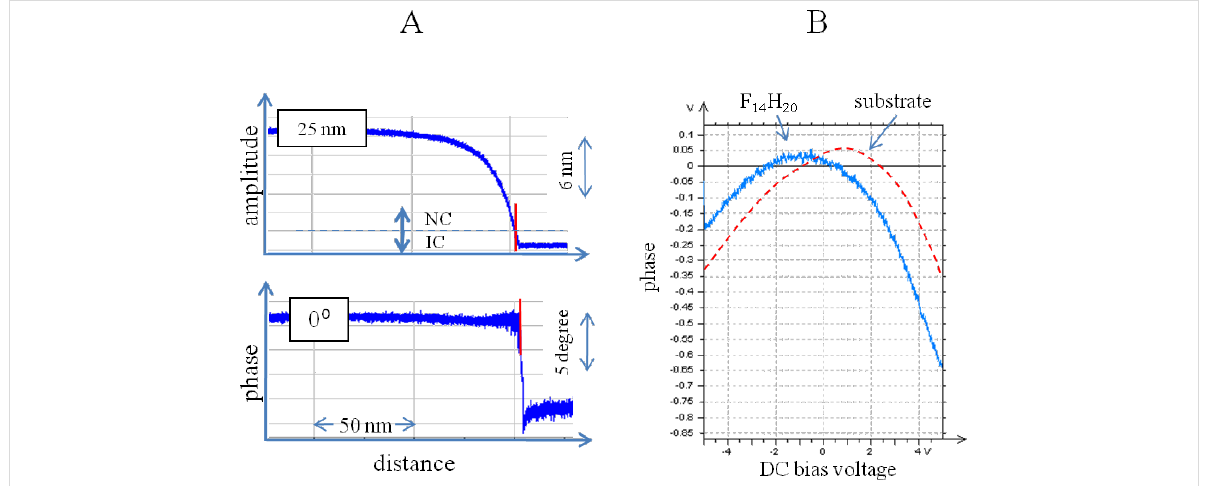
Figure 2: A – Graph showing a temporal change of amplitude and phase of the AFM probe on approach to a sample. The time axis is converted to distance axis. The initial value of the amplitude is 25 nm and phase − 0 degrees. A red vertical line shows a point where a sharp drop of the phase indicates contact with the sample. On the right side of the line the amplitude was reduced further to stay at the set-point level ( A sp ) corresponding to the intermittent contact regime. A horizontal dotted line marks the amplitude set-point level above and below which the non-contact (NC) and intermit- tent contact (IT) regimes take place, respectively. B – Graphs showing the electrostatic force induced phase changes as a function of DC bias voltage. The measurements were made on a sample of F 14 H 20 on Si substrate with the probe located above the F 14 H 20 self-assemblies (blue curve) and away from them (red curve).